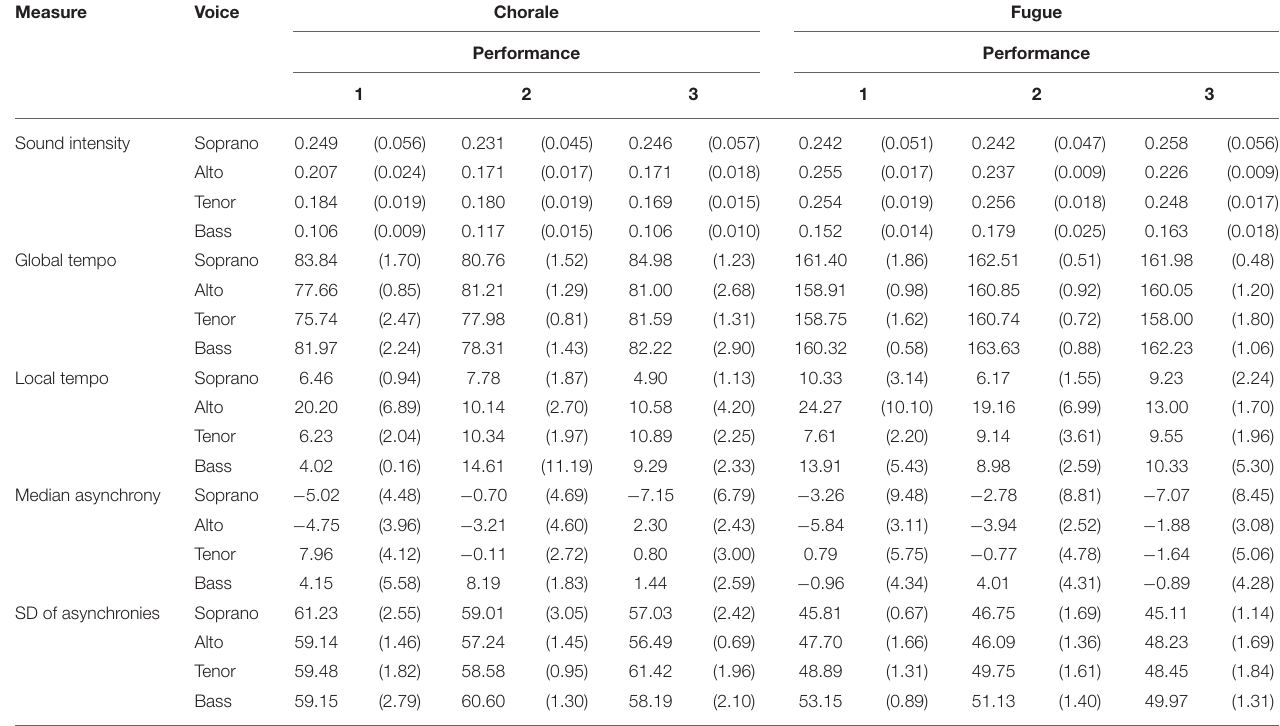
TABLE 1 | Measures of sound intensity (root mean square of amplitude profile), global tempo (bpm), local tempo variability (SD of onsets in tempo map), median asynchrony (in ms, relative to note onsets in mixed full choir file), and SD of asynchronies (ms) computed from individual audio files for three performances (females present in audience for performance 2) of two pieces (chorale and